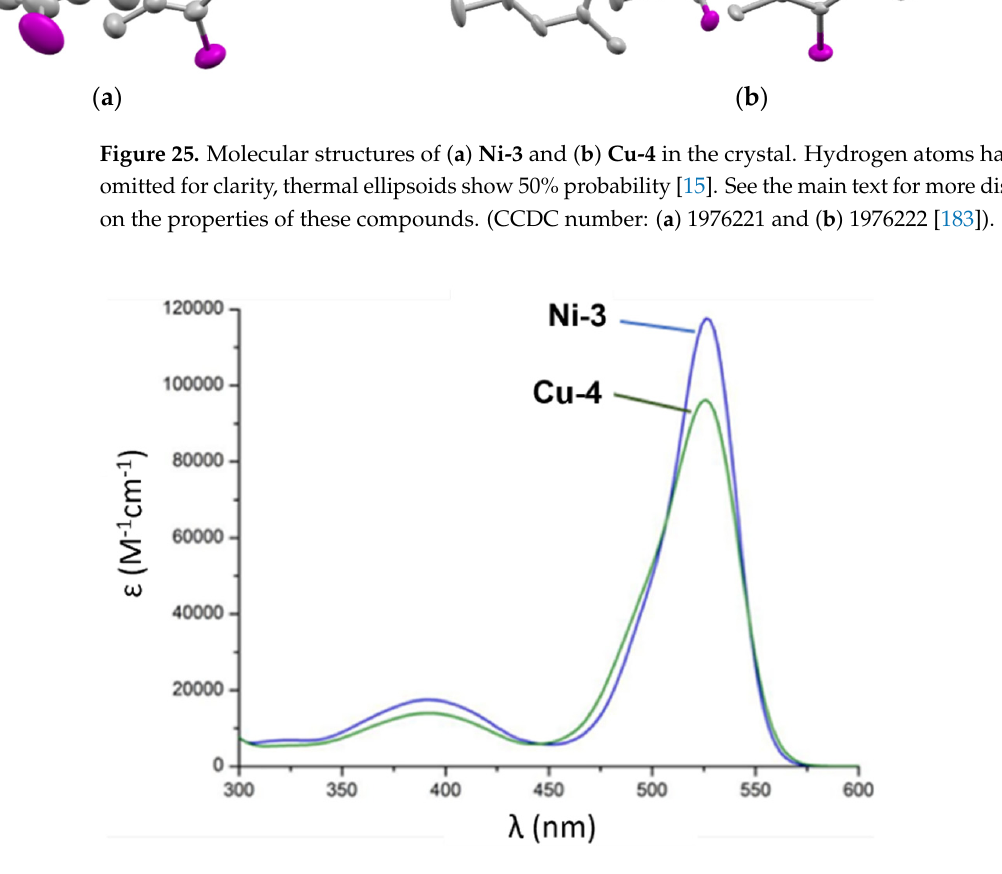
Figure 26. UV-vis absorption spectra of Ni-3 and Cu-4 in DCM. Reproduced with permission from [15]. Copyright © 2020 Elsevier B.V.